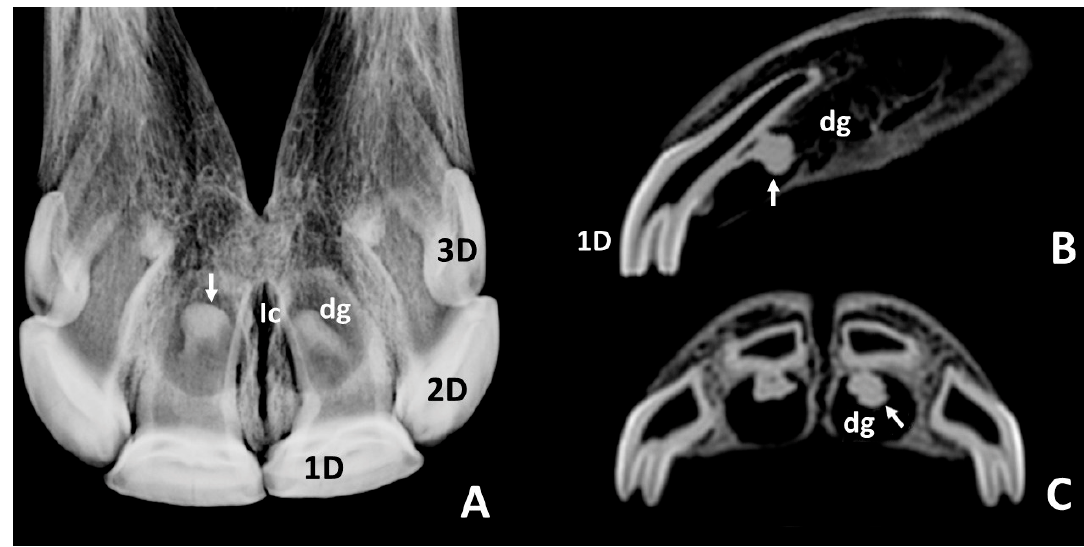
Figure 4. Intraoral radiographic images ( A ) and sagittal and transverse scans ( B , C ) of the maxillary incisor arcade of a skull representative of group 1b. 1D , left 1st deciduous incisor—601; 2D , left 2nd deciduous incisor—602; 3D , left 3rd deciduous incisor—603; dg , dental germ of left 1st permanent incisor—201; Ic , incisive canal; white arrows , circumscribed radiopaque ( A ) and hyperdense ( B , C ) images within the dental germs of left 1st permanent